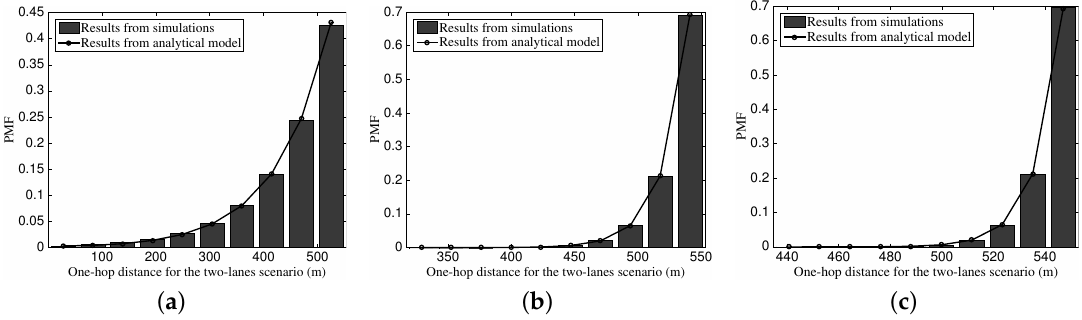
Figure 11. The PMF of one-hop transmission distance for the two-lane scenario with different vehicular traffic density, where v ∆ = 20 km/h. ( a ) ρ 1 = 10, ρ 2 = 5 vehs/km; ( b ) ρ 1 = 50, ρ 2 = 25 vehs/km; ( c ) ρ 1 = 100, ρ 2 = 50